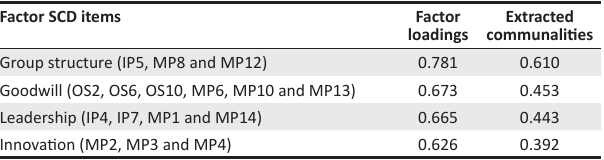
TABLE 4: Factor loadings and extracted communalities for structural capital disclosure. Factor SCD